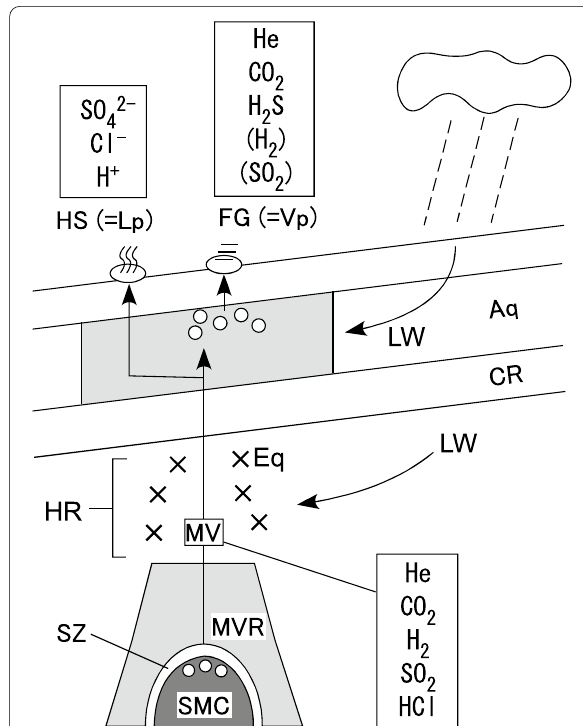
Fig. 8 Schematic illustration of local meteoric water (LW) in the shallow aquifer (Aq) beneath Ioyama volcano interacting with magmatic vapor (MV). MV is discharged from the shallow magma chamber (SMH). MV moves up through the sealing zone (SZ), the magmatic vapor reservoir (MVR), and caprock (CR). MV produces volcanic earthquakes (Eq) in the region between MVR and CR. Interactions between MV and LW produce the vapor phase ( V p) and the liquid phase ( L p). A portion of both the V p and L p are discharged at the surface as fumarolic gas (FG) and hot spring water (HS), respectively. A portion of the SO 2 in MV is converted to SO 42– ion and H 2 S gas, which are preferentially distributed to L p and V p, respectively